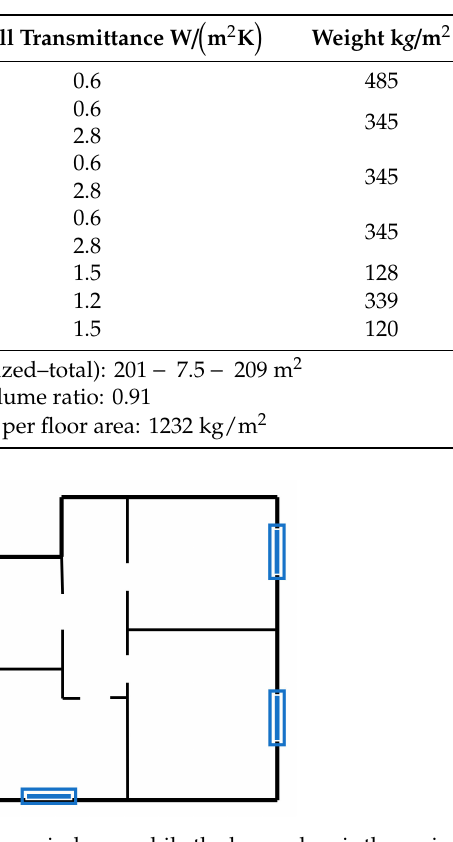
Table 3. Geometry and Thermal Characteristics of the Envelope.